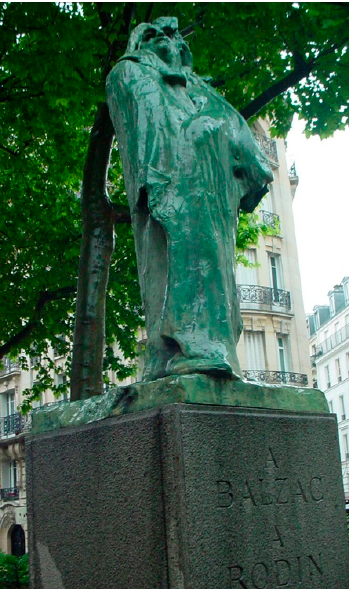
Figure 3. Monument to Balzac by Auguste Rodin, 1898. Bronze, 282 cm × 122.5 cm × 104.2 cm. Photo by the author.